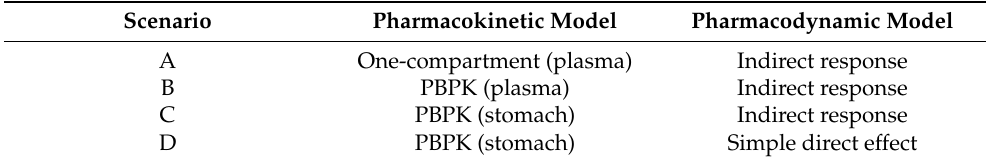
Table 1. Four PK–PD modeling scenarios for orally administered fexuprazan. The PK models are one-compartment and PBPK, while the PD models are indirect response and simple direct